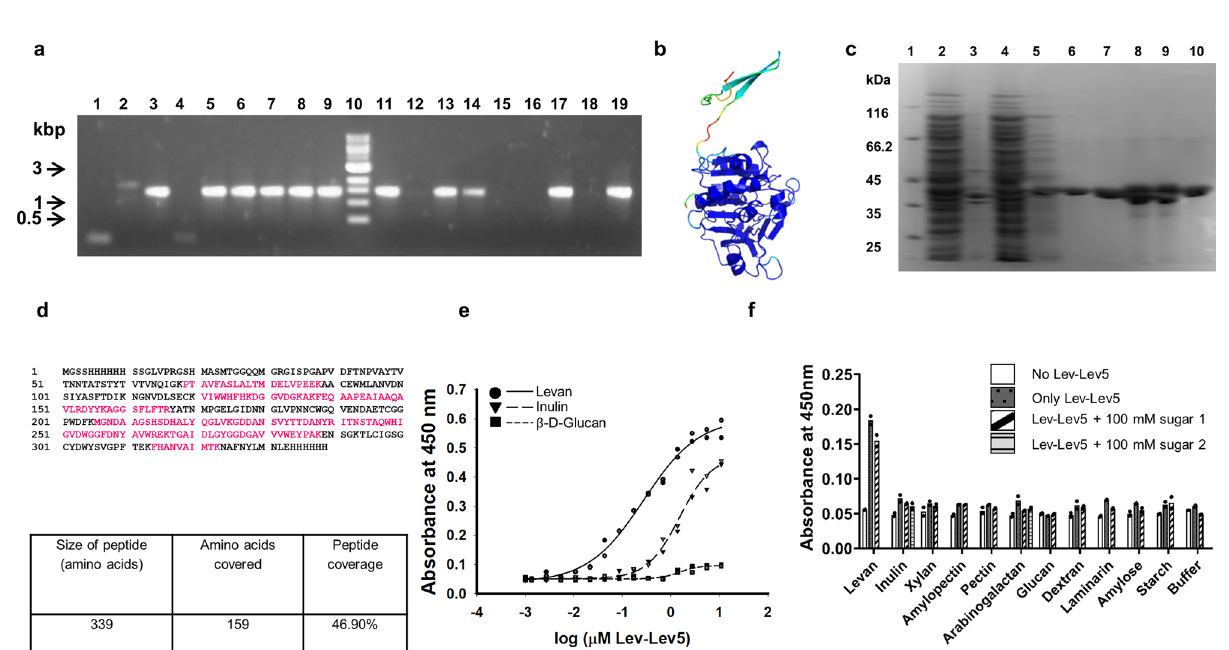
Fig. 5 Identi fi cation of a levan binding protein domain. a Agarose gel electrophoresis of PCR amplicons indicating the presence or absence of any recombinant insert following biopanning of the metagenomic phage display library against levan and elution with D-fructose or levan. Results of a single screening experiment. Lanes 1 – 9: PCR amplicons of clones Lev-Fru1 to Lev-Fru9. Lane 10: 1 kbp DNA marker. Lanes 11 – 19: PCR amplicons of clones Lev-Lev1 to Lev-Lev9. b AlphaFold2 predicted structural model of Lev-Lev5. c Coomassie blue stained SDS-PAGE showing puri fi ed Lev-Lev5 protein following